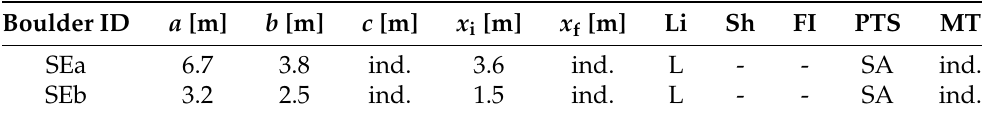
Table A16. Main features of the displaced boulders at the Torre Sant’Emiliano coast; see the caption of Table A2 for